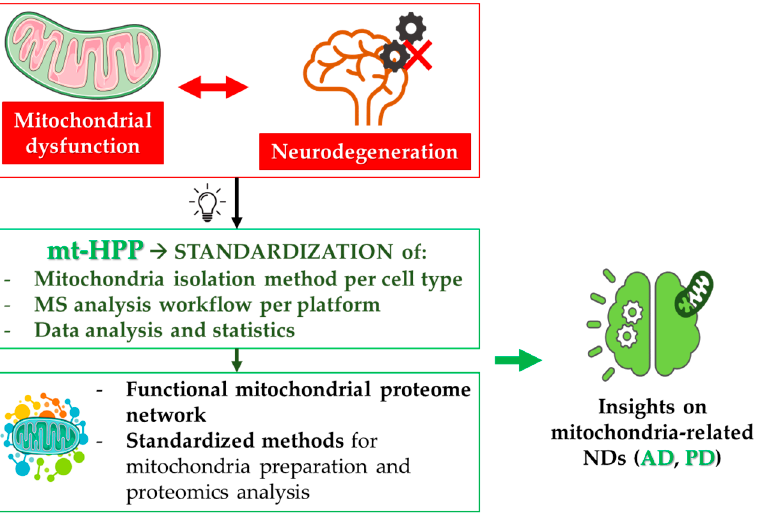
Figure 4. Mitochondria and neurodegeneration. Mitochondrial dysfunction represents one of the most frequent pathological alterations in NDs. Indeed, the failure of the tightly regulated mitochondrial quality control contributes to neuron death. The mitochondria-centered initiative of the Human Proteome Project (mtHPP), which aims at the in-depth investigation of the mitochondrial proteome in health and disease, has enabled the standardization of procedures related to mitochondria isolation and quantitative analysis of mitochondrial proteins (see Section 4.1). The fulfillment of the objectives of this project will achieve important advances in the understanding of several NDs, especially AD and PD (see sections 4.2 and 4.3, respectively).